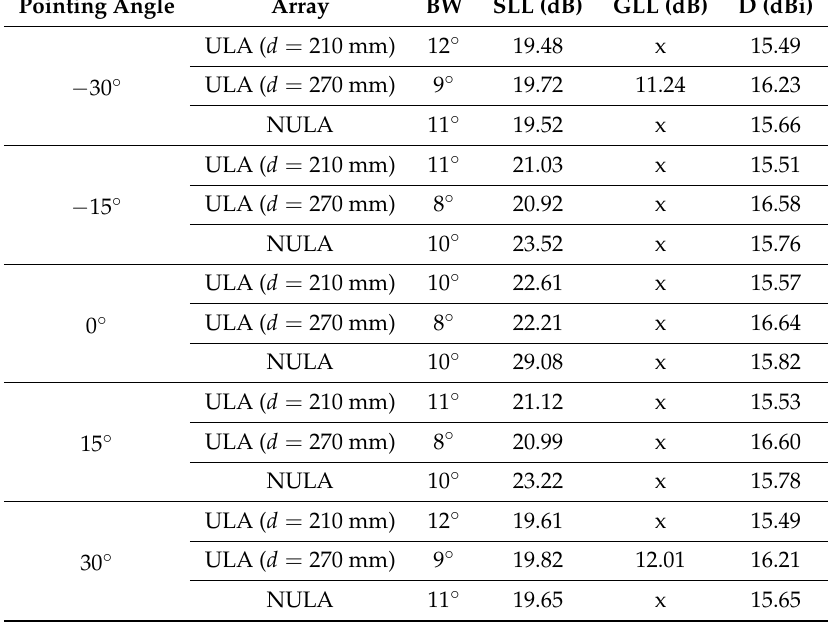
Table 7. Main characteristics of the azimuth plane radiation patterns generated with the SLL control weighting vector of the ULAs with inter-element spacings of 210 mm and 270 mm and the NULA designed in Section 3.2, for N = 11 commercial antennas. The considered steering angles are φ = [ − 30, − 15,0,15,30 ] ◦